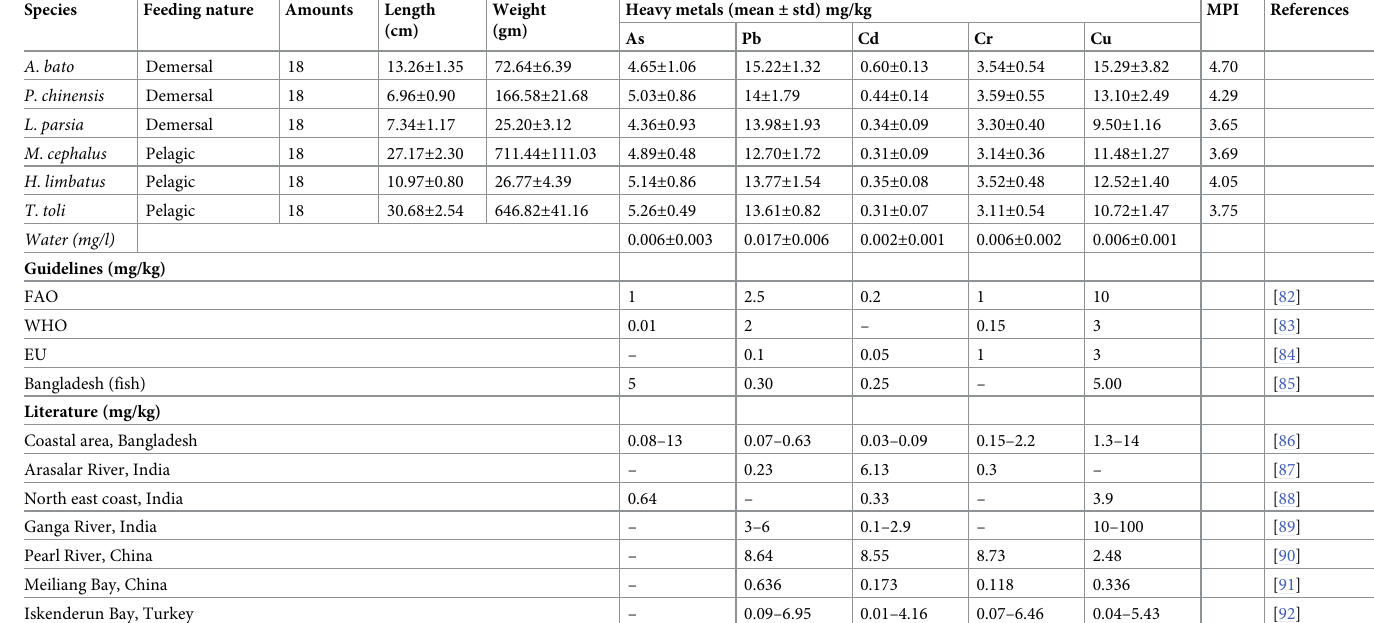
Table 1. Concentration of heavy metals of different species and their feeding nature, length and weight and a comparison of other relevant studies along with vari- ous standard guideline values.